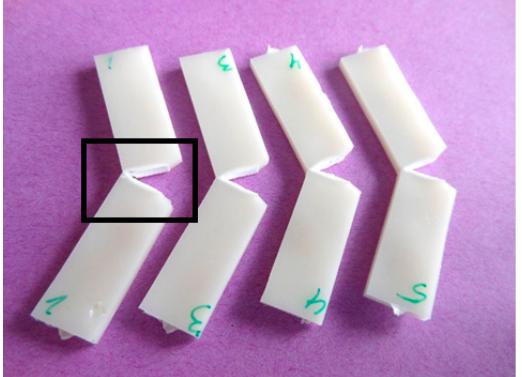
Figure 8. Fracture in PLA/Hytrel-20% impact test samples (stress-whitening zone contoured in black).